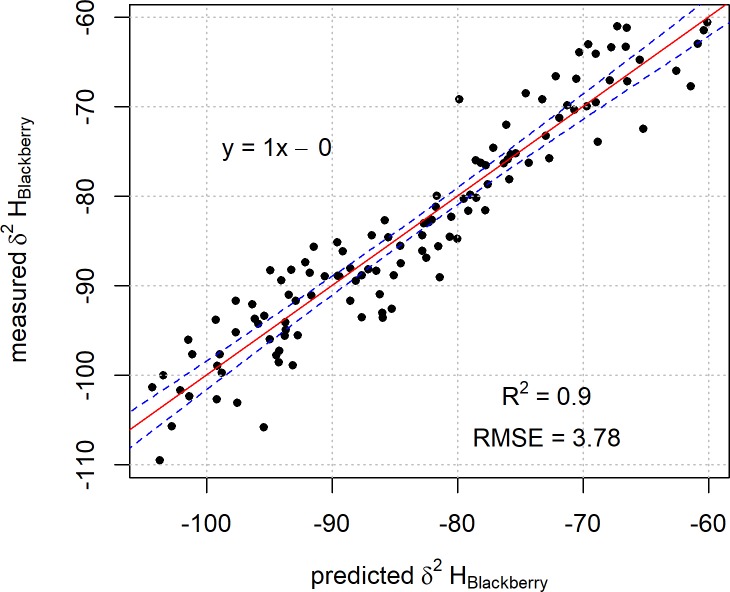
Plot of predicted blackberry leaf δ2H values based on Model 2 against the measured blackberry leaf δ2H values.The linear regression line of best fit is represented by the red line with 99% confidence intervals for the fit in blue.